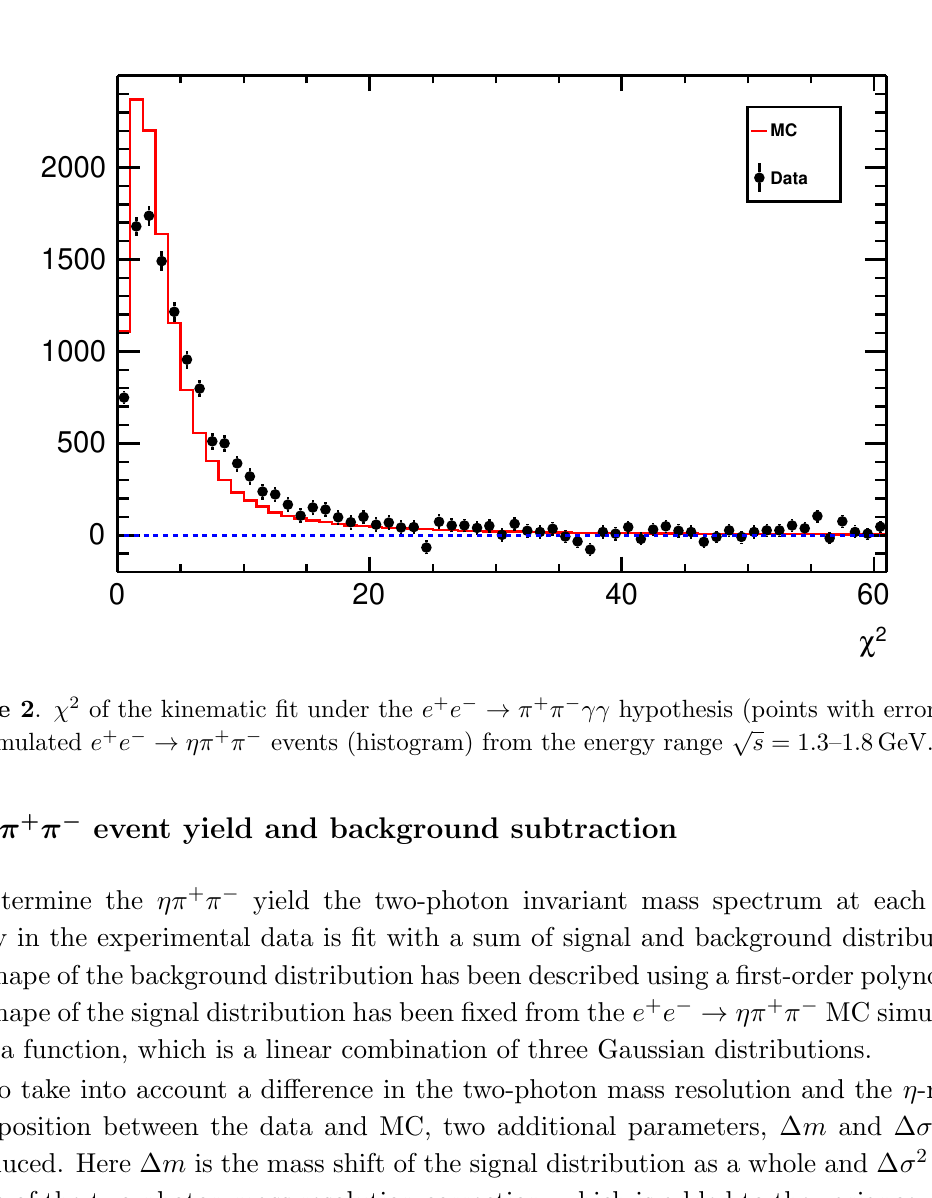
p s = 1 : 3{1 : 8 GeV.